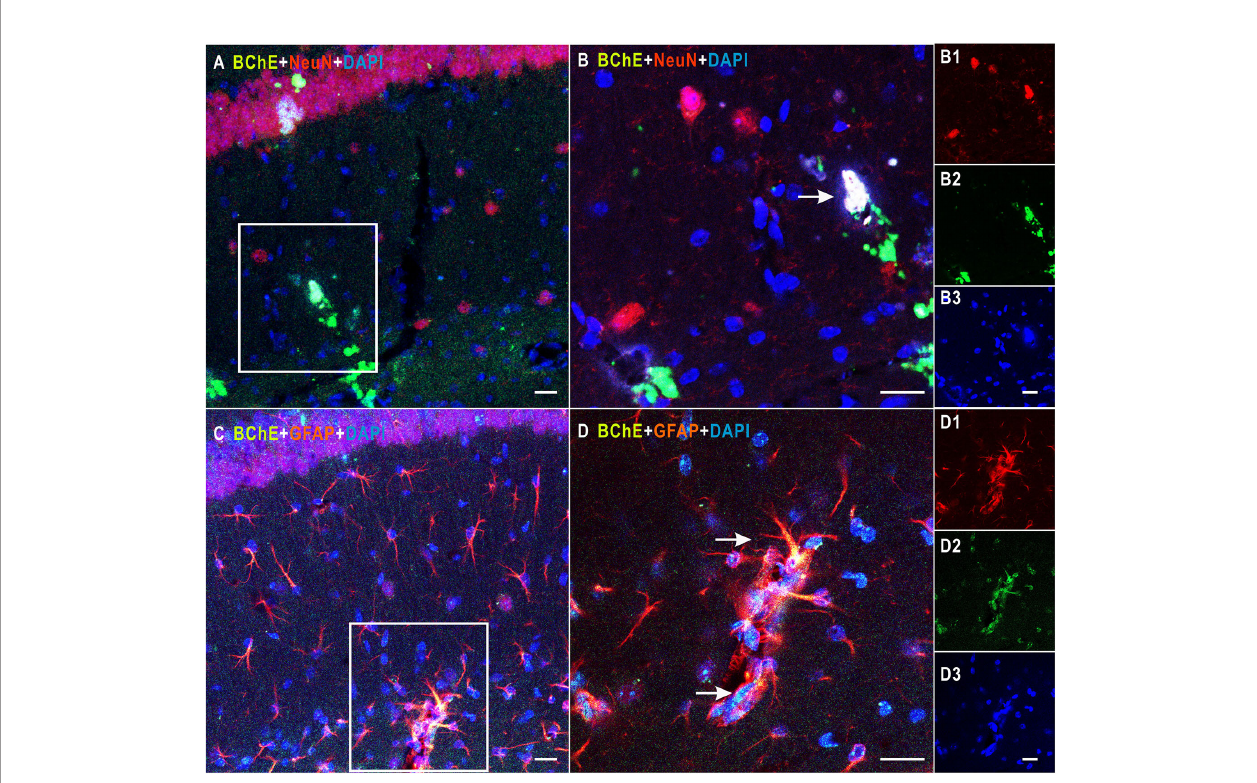
FIGURE 1 | Detection of colocalization of BChE and GFAP or NeuN in the hippocampal CA1 area. (A) BChE (green), NeuN (red), and BChE-NeuN colocalization (yellow) were observed in the hippocampal CA1 region. (B) Picture (B) is a magni fi ed image of the white box in (A) . B1 – B3 shows single staining in (B) . BChE (green), NeuN (red), and DAPI (blue) staining are shown. (C) BChE (green), GFAP (red), and BChE-GFAP colocalization (yellow) were observed in neurons in the hippocampal CA1 region. (D) Picture D is a magni fi ed image of the white box in (A) . D1 – D3 shows single staining in (B) . BChE (green), GFAP (red), and DAPI (blue) are shown. Pictures (A, C) , (B, D) , and B1 – B3 and D1 – D3 are the same magni fi cation. Scale bar: 20 m